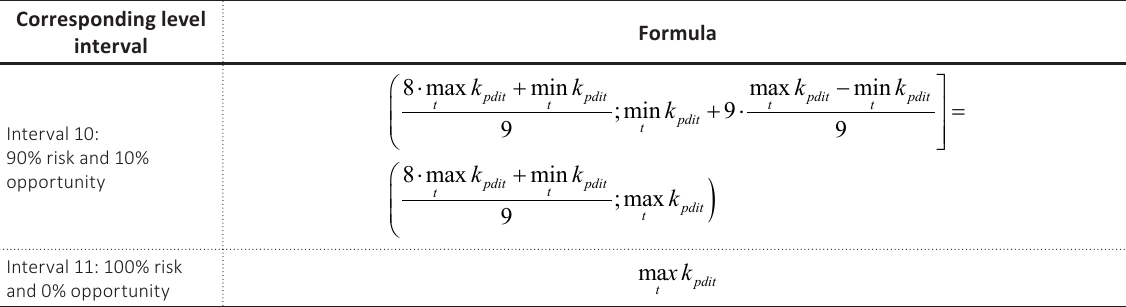
Table A1 (cont.). Formulas of a fuzzy-logic approach to assessing indicators in terms of the risk of their impact on the overall level of financial